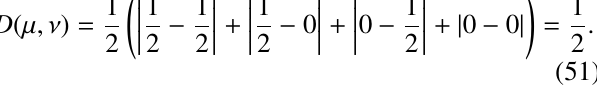
Figure 10: Hierarchy of constraints on ontological models of quantum theory. Properties that appear higher in the diagram imply those that they are connected to lower down. Non maxi- mal ψ -epistemicity can be derived from either ψ -ontology or Kochen–Specker